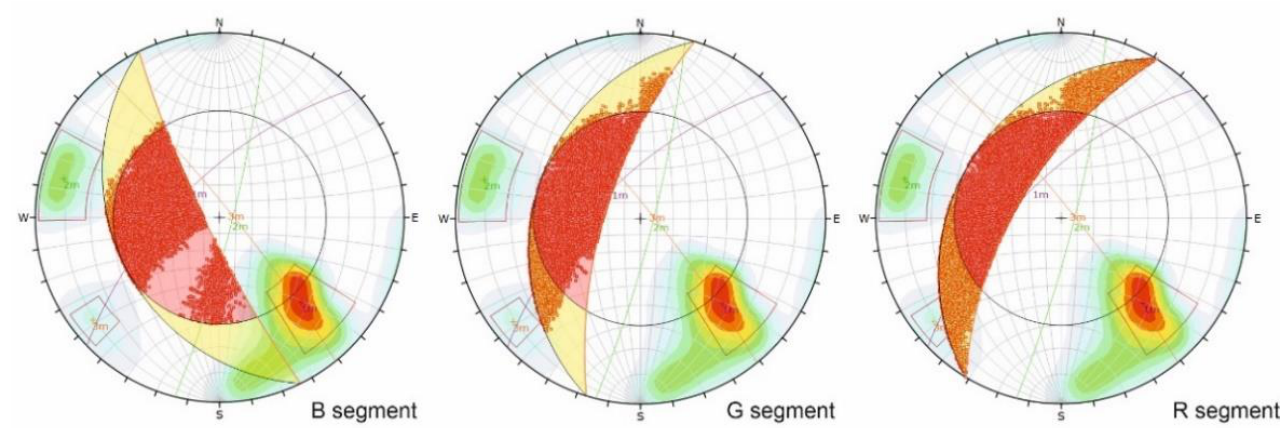
Figure 9. Wedge-sliding risk analysis for the three individual segments of Porto Katsiki beach (B for blue morphological plane, G for green morphological plane, R for red morphological plane of Figure 8d).